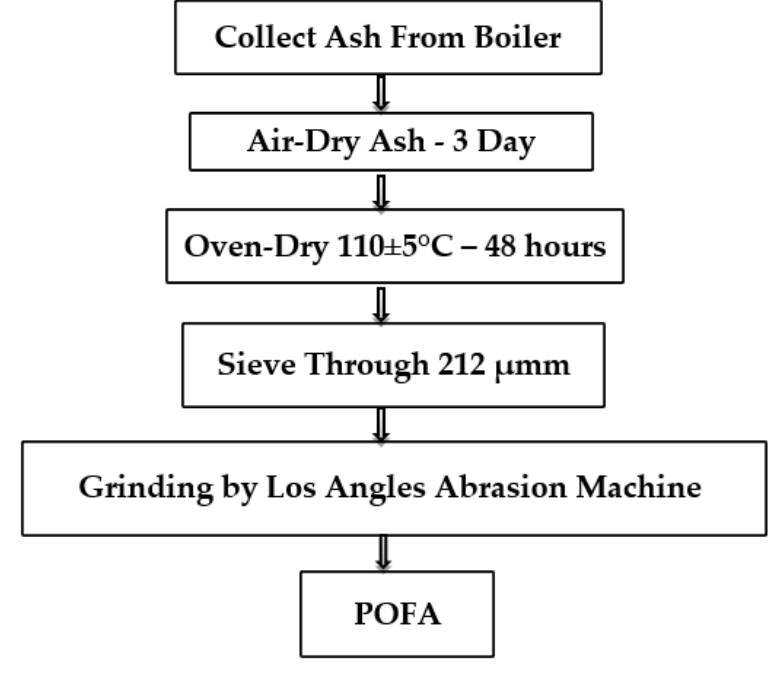
Figure 1. POFA preparation process for use in concrete.